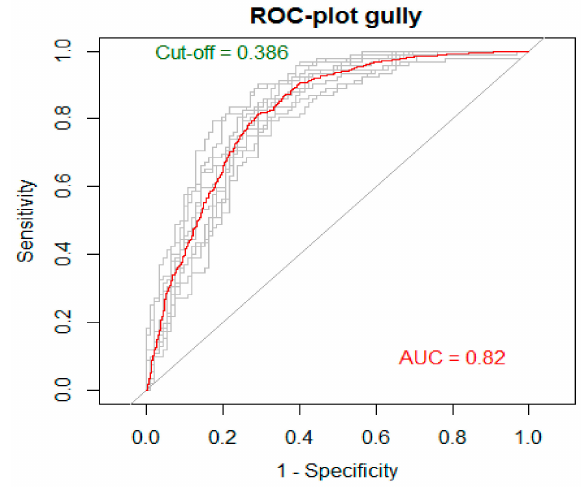
Figure 6. Average Receiver Operating Characteristic (ROC) curves for the MARS model through 10 replicates.